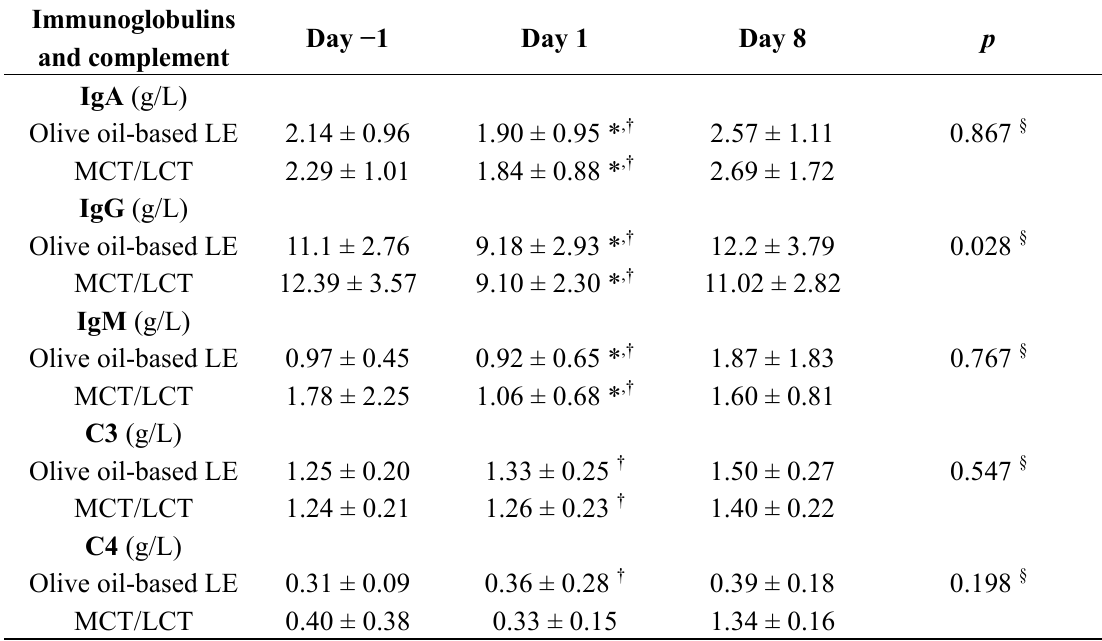
Table 4. Comparison of immunoglobulins and complement between the two